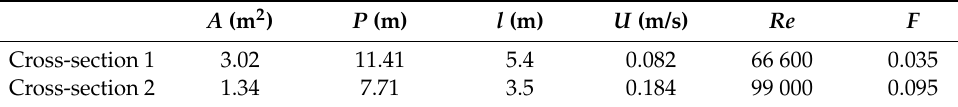
Table 3. Hydraulic parameters of both cross-sections 1 and 2. A = cross-sectional area; P = cross- sectional perimeter; l = river surface width at the cross-section; U = mean velocity calculated by divid- ing the measured flowrate by the cross-sectional area; Re = Reynolds number; F = Froude